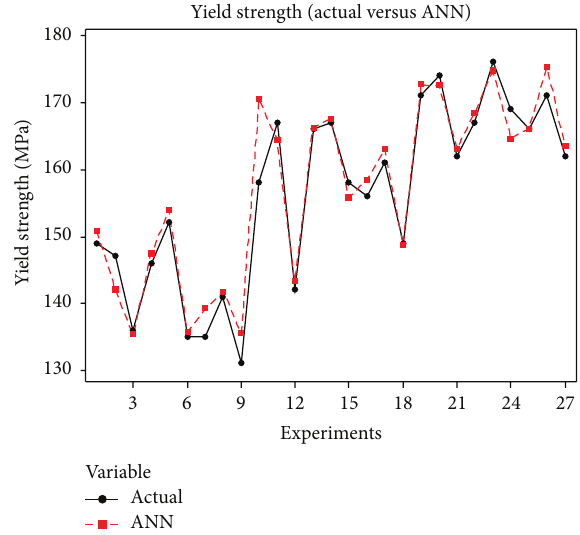
Figure 8: Actual versus ANN predicted results for YS.